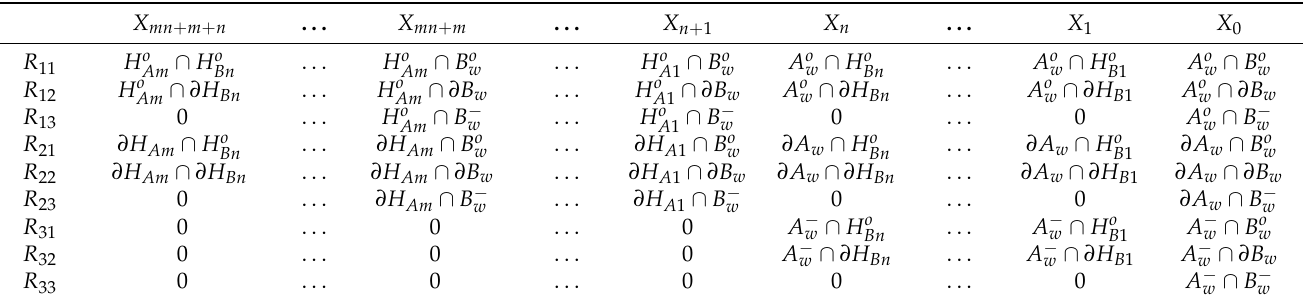
Table 2. Intersecting components in elements of R G 9 IM